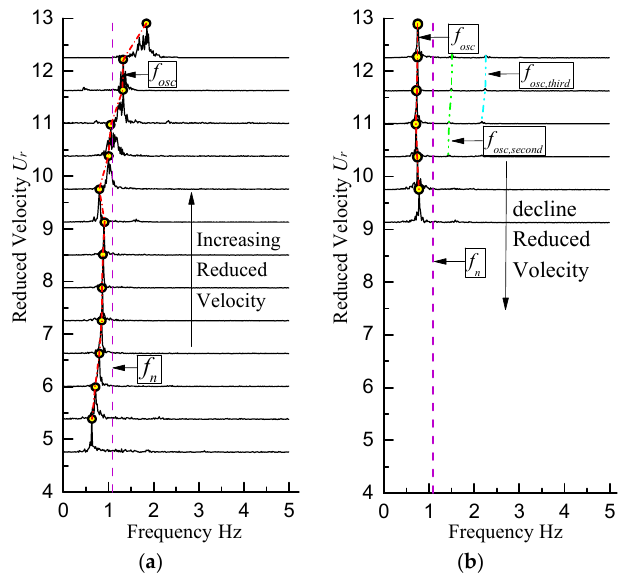
Figure 13. Typical oscillation frequency spectrum: ( a ) complete VIV branch; ( b ) galloping branch. Table 4. Oscillation form and parameters list.